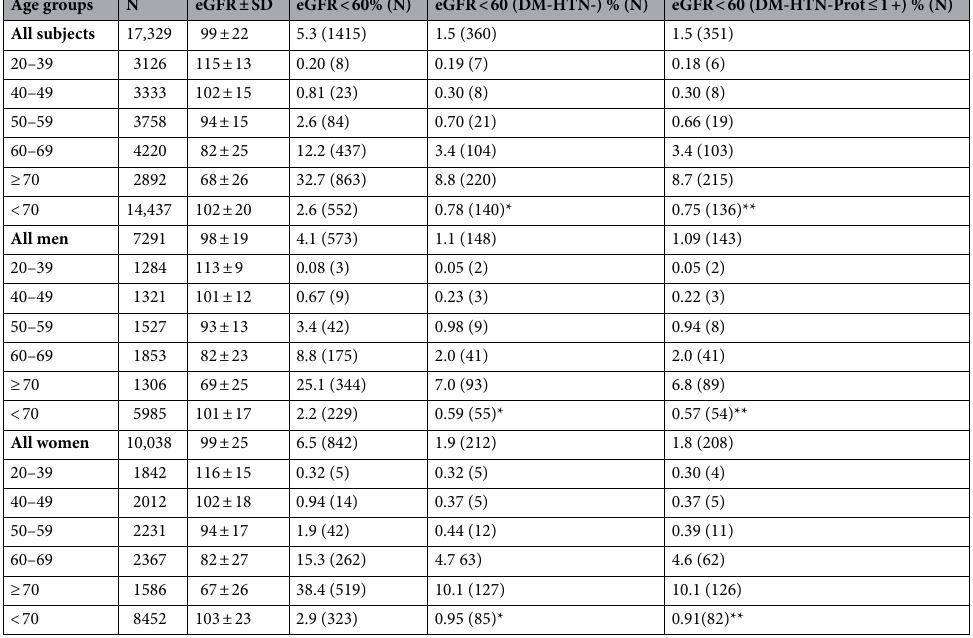
Table 2. GFR and adjusted prevalence of decreased GFR and CKDu by age and sex. N = number within group; % = adjusted percent-probability weighted for the registered 2014 Thai population stratified by age, sex, area of residence (urban/rural), geographic region; eGFR < 60, decreased GFR-all causes; eGFR < 60 (DM-HT-), decreased GFR without diabetes or hypertension; eGFR < 60(DM-HT-Prot ≤ 1 +), decreased GFR without diabetes, hypertension or heavy proteinuria. *CKDu1;